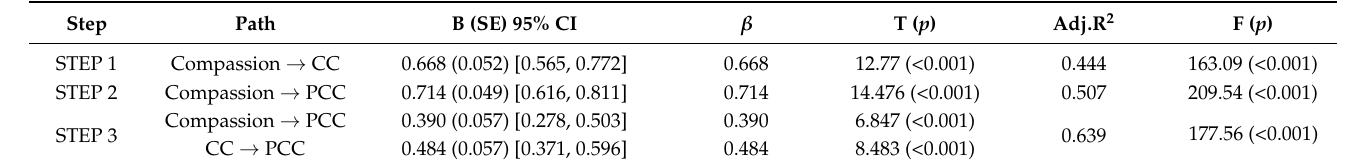
Table 3. Mediating effects of CC on the relationship between compassion and PCC ( N =